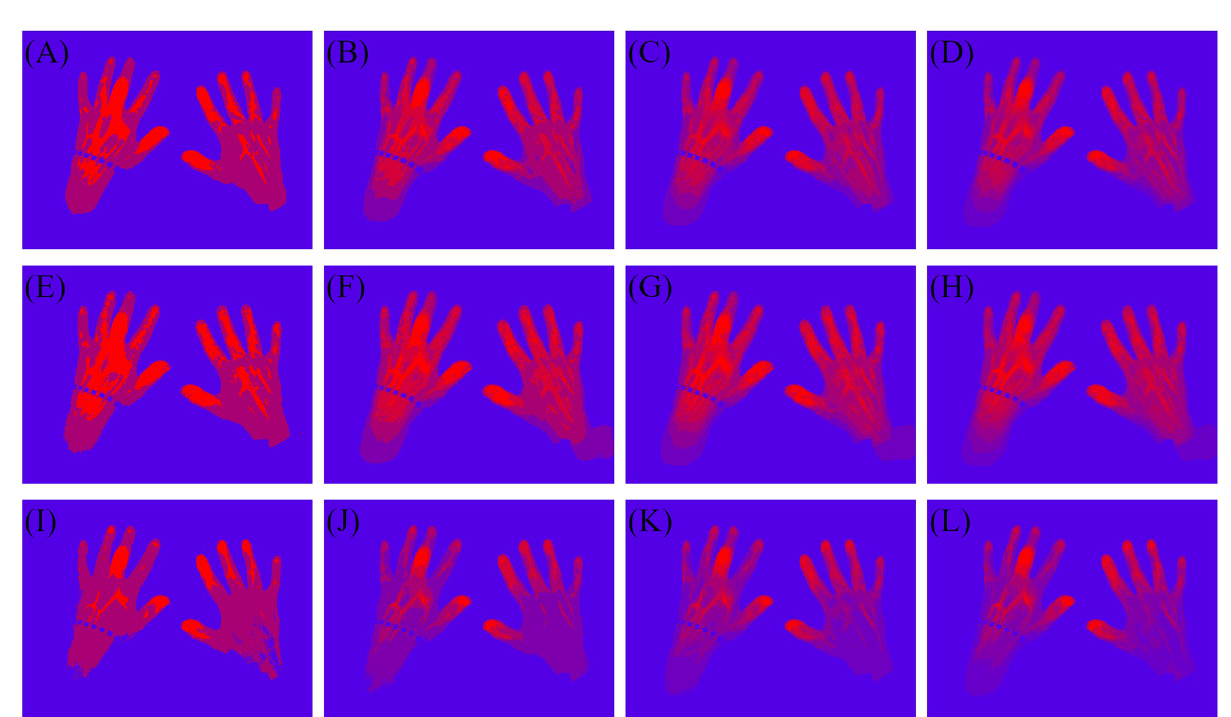
Fig 4. Calculated heatmaps for the three features. The row specifies the feature and the column the amount of cluster used creating the heatmap. For this example the slope feature (third row) emphasise the different health conditions of the joints. In the slope three cluster heatmap the right DIP II joint is assigned to the same cluster as the left PIP III joint. The slope seven and slope nine cluster heatmap represent the actual inflammatory condition better and show a clear distinction between right DIP II and left PIP III joints. For different examples each feature shows a different classification power. (A) 3 cluster amplitude. (B) 5 cluster amplitude. (C) 7 cluster amplitude. (D) 9 cluster amplitude. (E) 3 cluster mean. (F) 5 cluster mean. (G) 7 cluster mean. (H) 9 cluster mean. (I) 3 cluster max slope. (J) 5 cluster max slope. (K) 7 cluster max slope. (L) 9 cluster max slope.